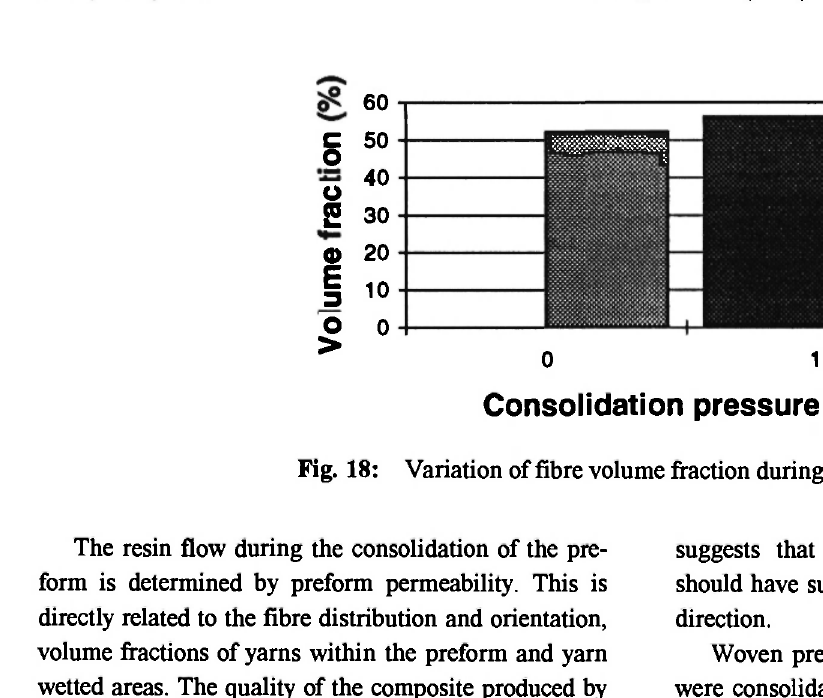
Fig. 18: Variation of fibre volume fraction during